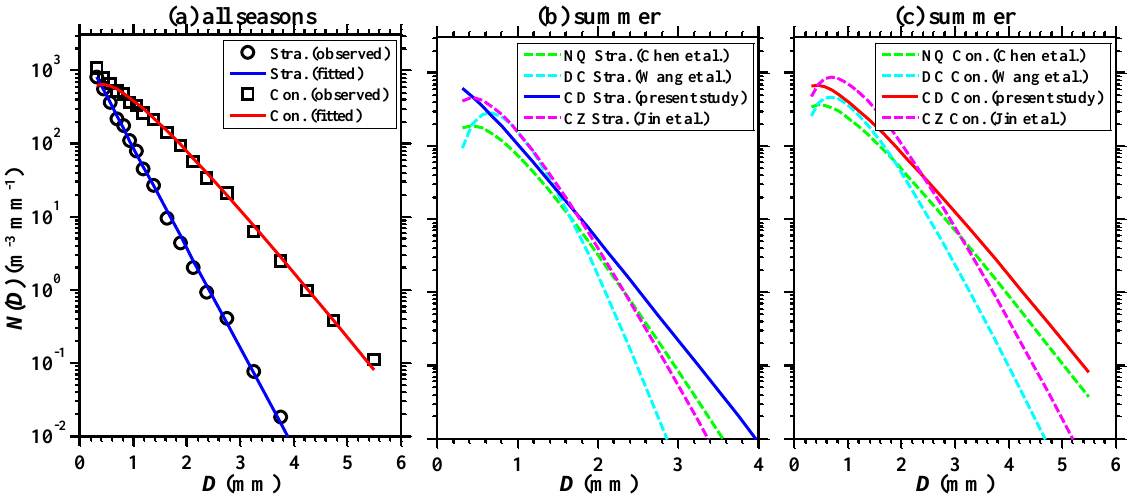
Figure 6. Composite RSDs for all seasons ( a ) and comparisons of the summer precipitation among four similar-latitude regions ( b , c ). NQ, DC, CD, and CZ denote Naqu (located in the mid-Tibetan Plateau, Chen et al., 2017 [22]), Daocheng (located in the eastern Tibetan Plateau, Wang et al., 2020 [13]), Chengdu (present study), and Chuzhou (located in the east China, Jin et al., 2015 [35]).